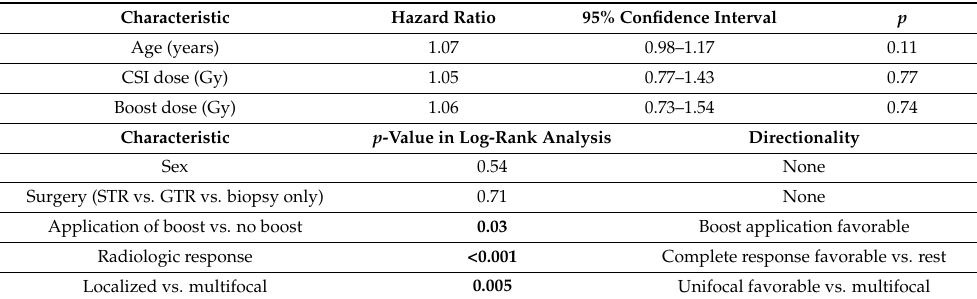
Table 3. Prognostic parameters in the CSI group. Cox proportional hazard regressions were used for continuous variables while log-rank tests were performed for dichotomous